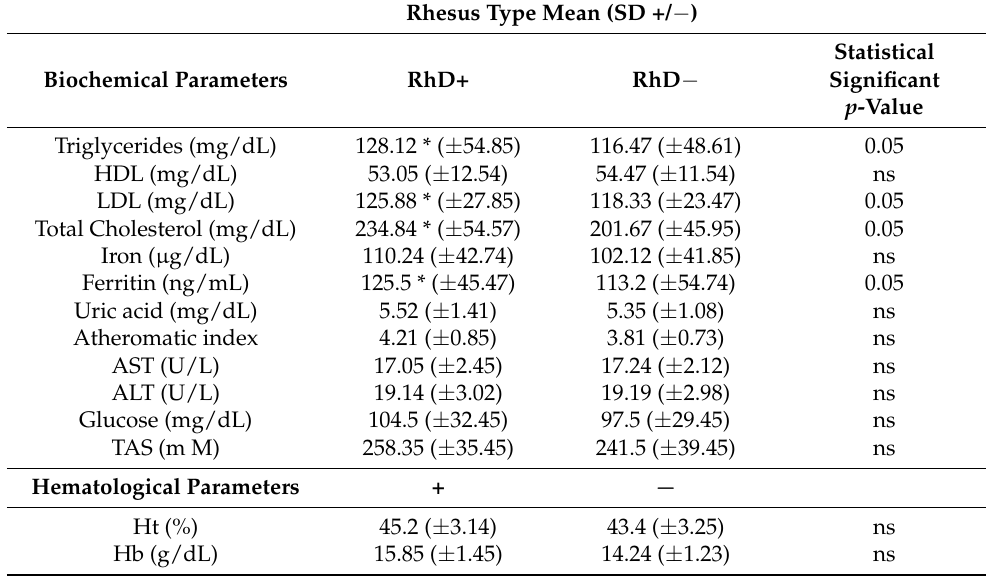
Table 4. Biochemical and hematological parameters related to Rhesus